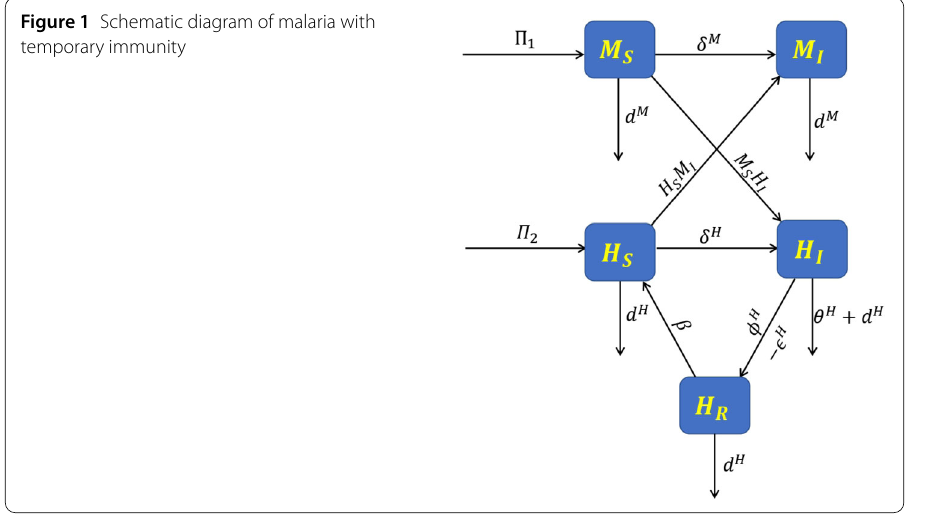
Figure 1 Schematic diagram of malaria with temporary